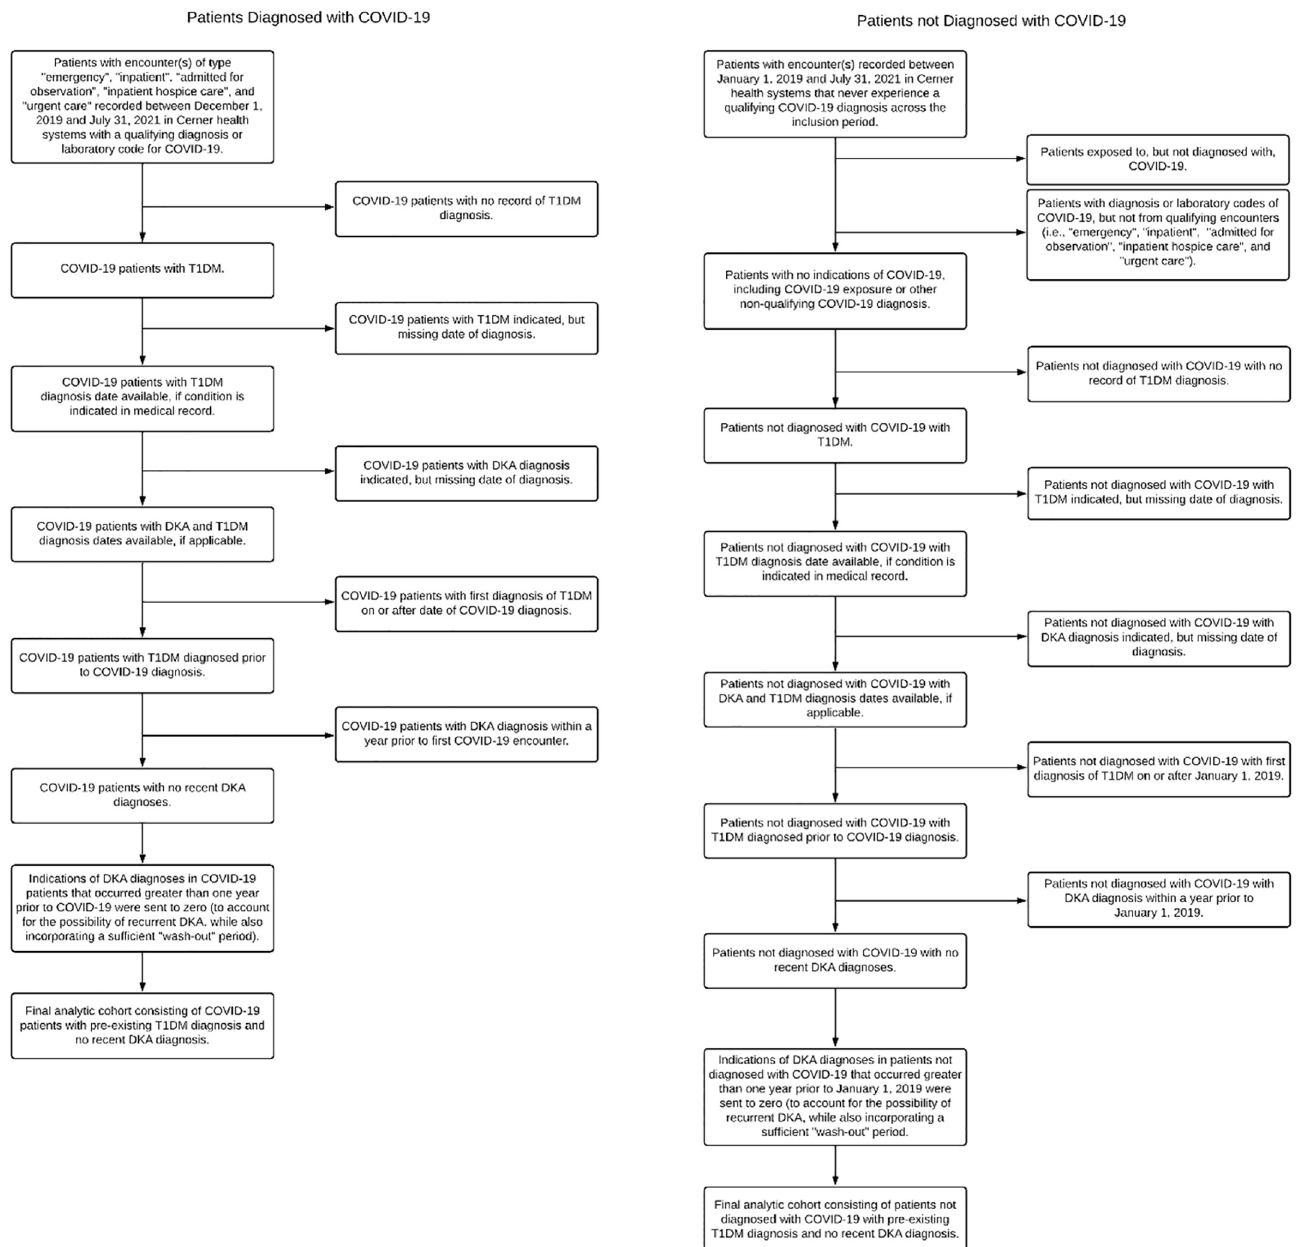
Fig 2. Inclusion and exclusion criteria used to generate the final analytic cohort consisting of patients with pre-existing T1D, no recent DKA diagnosis, non- recent DKA indications removed, and appropriate diagnosis dates known. Data were used to assess the extent to which COVID-19 diagnosis increases the risk of DKA among those with pre-existing